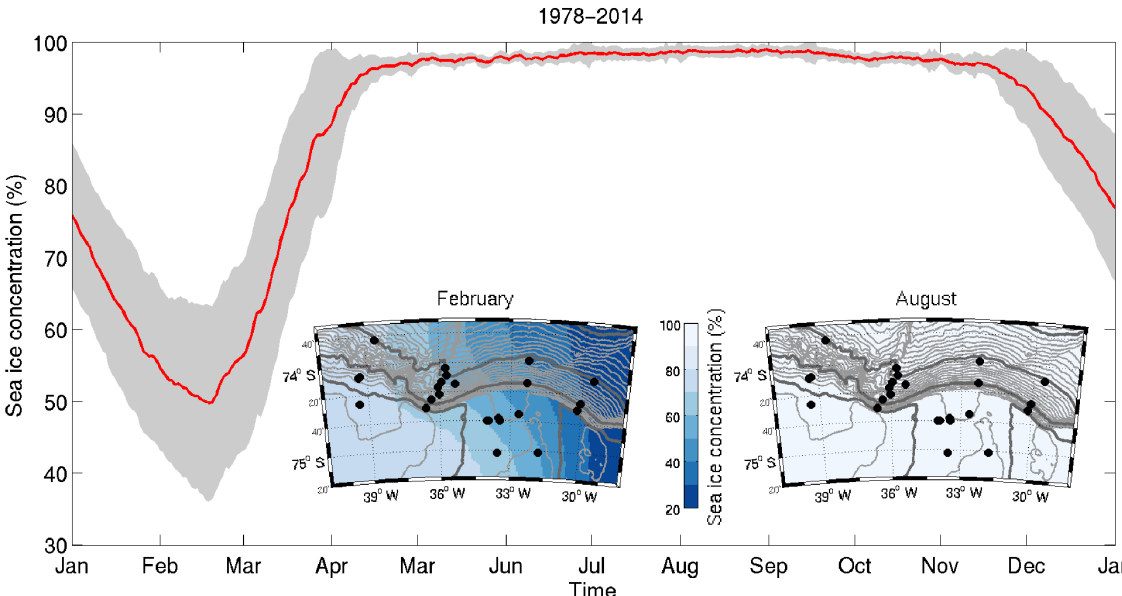
Figure 14. Sea ice concentration averaged over the study area and the period 1978–2014 (red line) with standard deviation (grey). Insets show maps of mean sea ice concentrations in February and August; isobaths and mooring locations (black dots) are as in Fig.